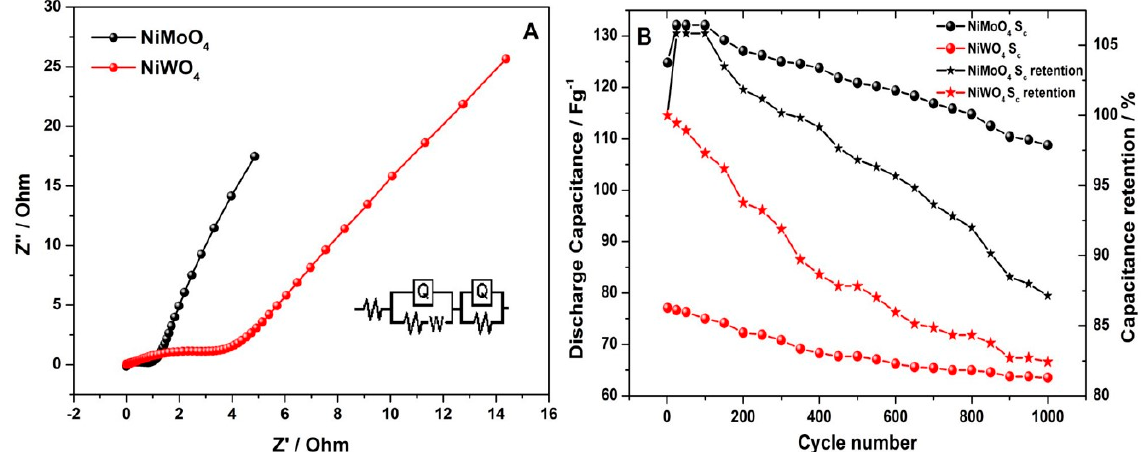
Figure 13. ( A ) Electrochemical impedance spectroscopy (EIS) results of NiMoO 4 and NiWO 4 hybrid cells presented as a comparative Nyquist plot and ( B ) cycle stability at an applied current density of 5 mA cm –2 demonstrating the device capacitance and its retention percentage.